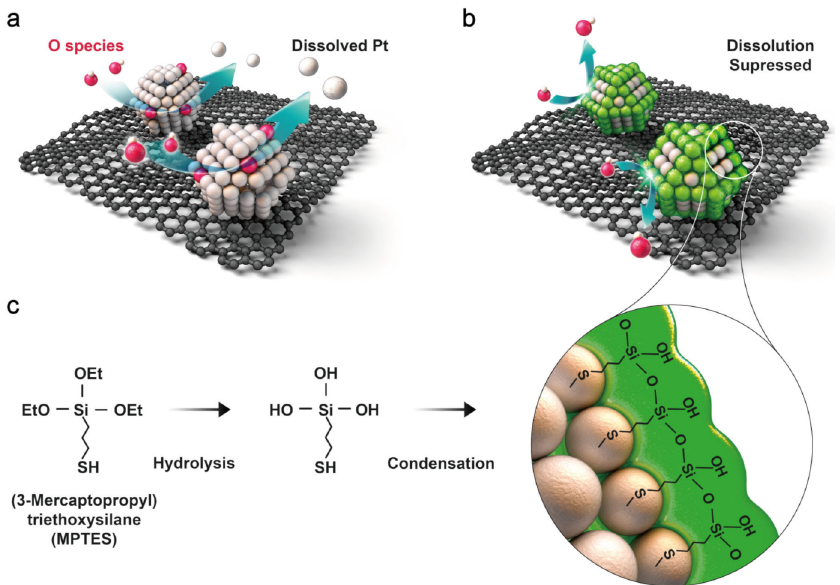
Figure 1. Facet-preferential protection of Pt nanoparticle. Schematic of ( a ), Pt dissolution at low coordinated Pt sites, ( b ), the preferential adsorption of (3-mercaptopropyl) triethoxysilane (MPTES) on edge and corner sites, and ( c ), the subsequent conversion of MPTES to silicon